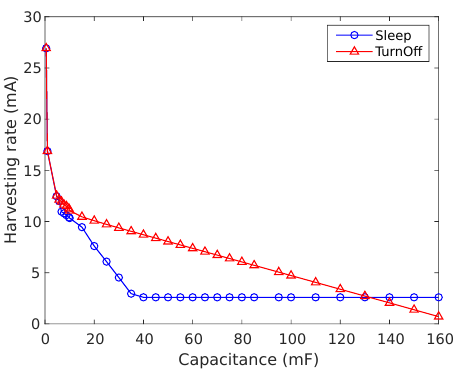
Figure 8. The minimum needed harvesting rates for the considered approaches as a function of